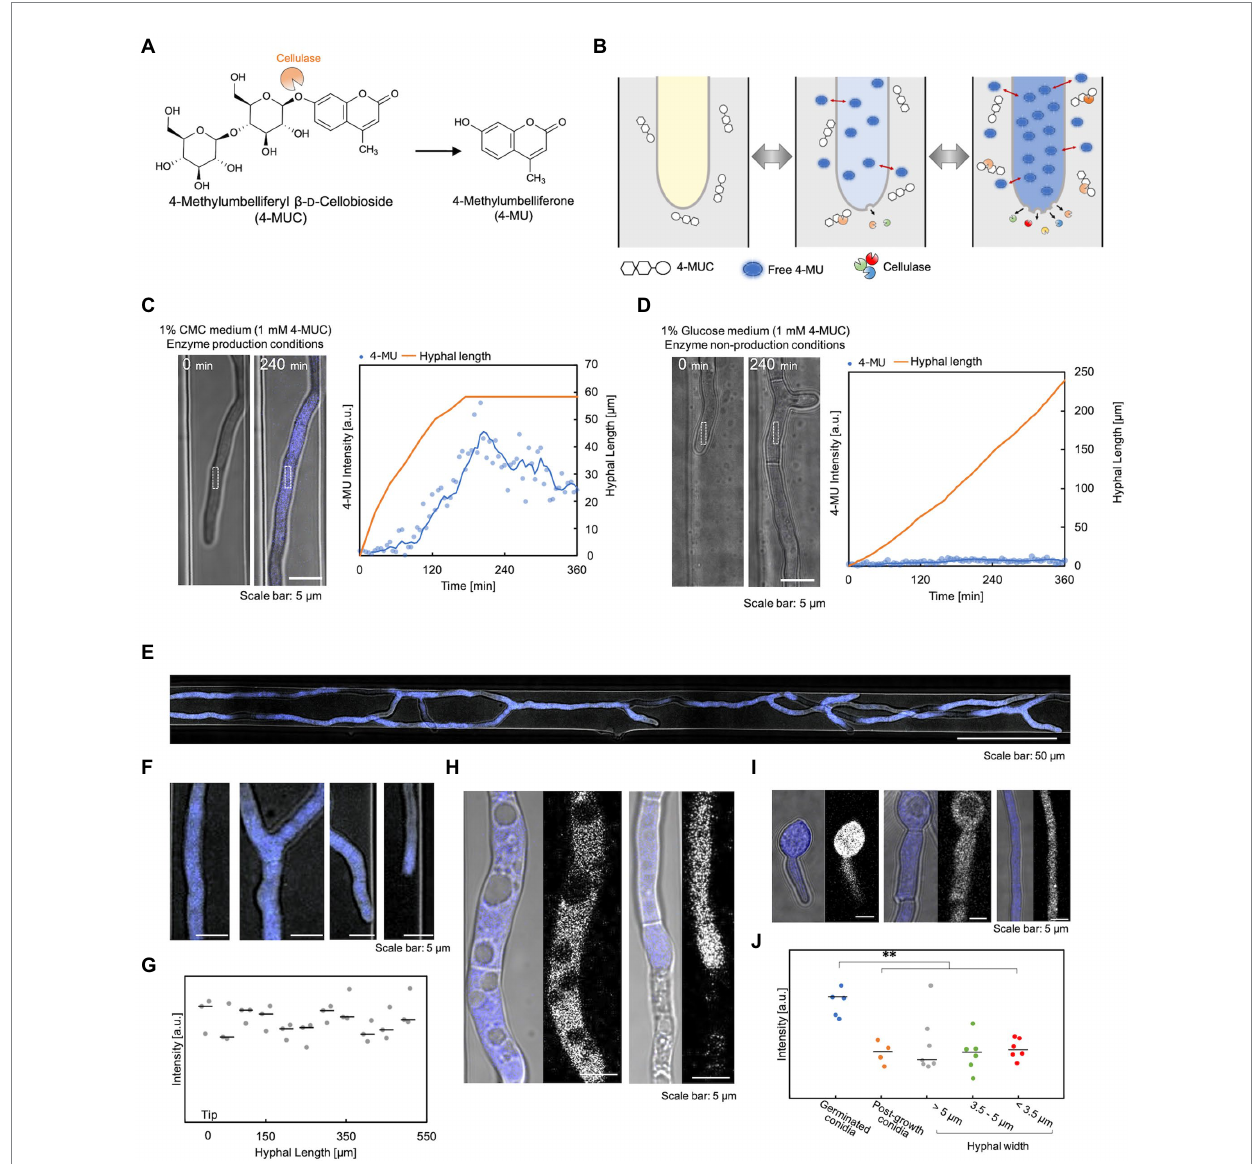
FIGURE 3 Verification of cellulase detection using 4-MUC. (A) 4-MUC releases 4-MU by cellulase. (B) Schematic illustration of the principle of cellulase detection by 4-MUC in the flow channel. (C,D) Hyphal growth and 4-MU intensity under the enzyme production condition (C) and under the enzyme non-production condition (D) . Left (microscopic image) and right (quantification of hyphal length and fluorescence intensity). (E–J) Differences in 4-MU fluorescence intensity in various hyphal conditions. (E) The overall image of the hypha. (F) Enlarged image of (E) . From left to right: hyphal base, branching, branched tip, and leading hyphal tip. (G) Fluorescence intensity from the tip (0 μ m) to 500 μ m. (H) 4-MU was not detected in vacuoles or dead cells. (I) Hyphal thickness and fluorescence intensity. From left to right: spores immediately after germination, spores and thick hyphae (hyphal width: about 5 μ m) after hyphal elongation, and thin hyphae (hyphal width: about 3.5 μ m). (J) Fluorescence intensity in hyphae of various widths. ** p ≤